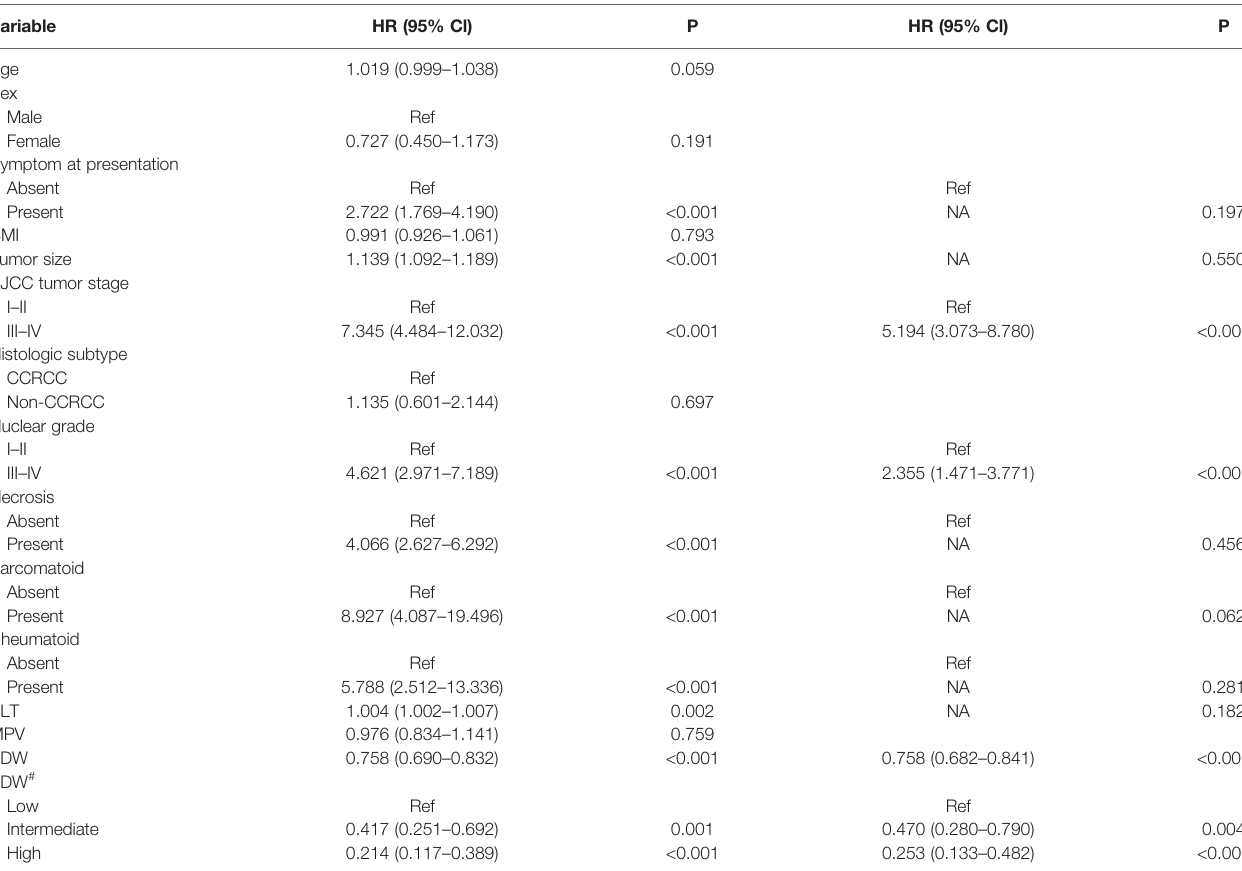
TABLE 3 | Univariable and multivariable analysis predicting progress free survival of nonmetastatic renal cell carcinoma.